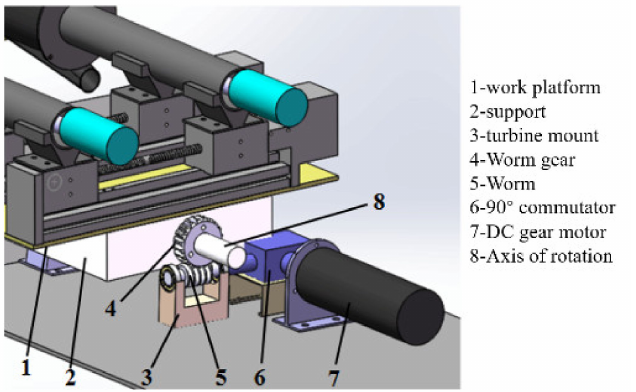
Figure 3. Double cutter changing device.